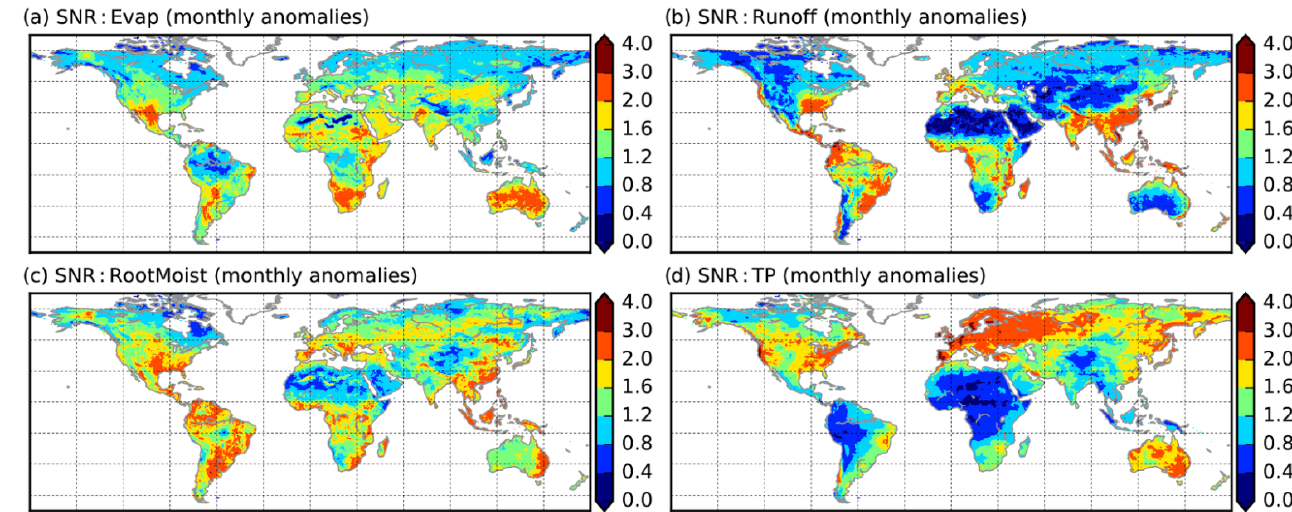
Figure 2. Signal-to-noise ratio of monthly mean anomalies of evapotranspiration (a) , runoff (b) , root zone soil moisture (c) and precipitation (d) .